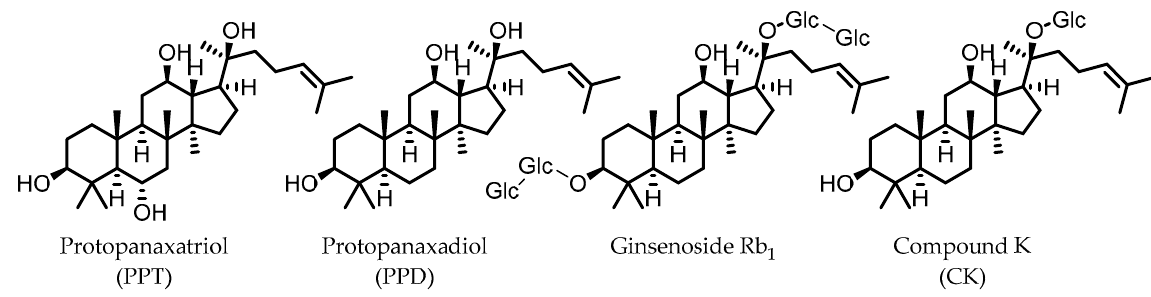
Figure 9. Structures of protopanaxatriol, protopanaxadiol, ginsenoside Rb1, and compound K. (Glc = glucose).